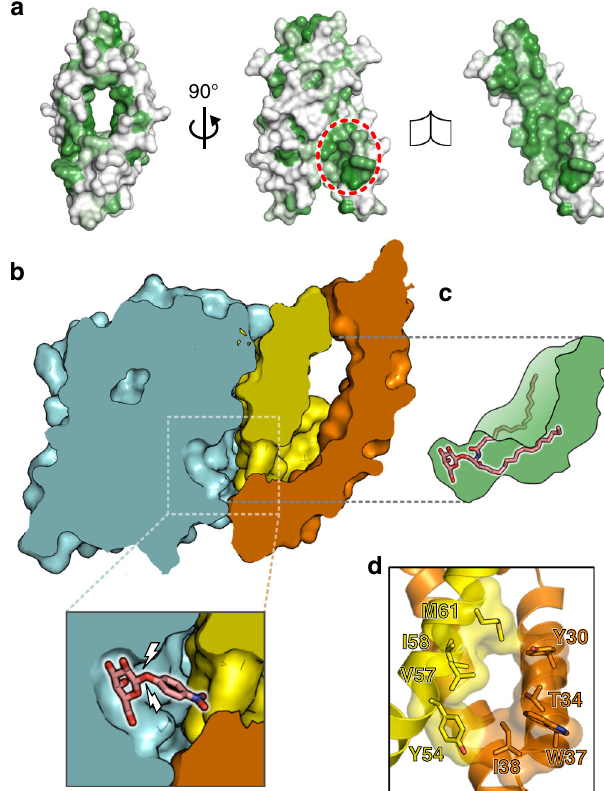
Fig. 3 The GALC – SapA structure reveals a hydrophobic channel buried in the core of the complex. a Residue hydrophobicity (green) is mapped onto the surface of the SapA dimer. The left panel is in the same orientation as shown in Fig. 2c, while the central panel is rotated by 90° to be in the same orientation as Fig. 2d. The region that binds over the GALC active site is circled (red dashed line). The right panel maintains the orientation of the central panel, with one SapA chain removed to reveal the highly hydrophobic inner surface of the SapA dimer. b Cross-section through the GALC – SapA structure reveals an open channel stretching from the GALC active site into the SapA hydrophobic cavity. The GALC surface and cut- through is shown in cyan and the SapA dimer surface is shown in yellow and orange. For clarity, the second GALC monomer is not shown. An